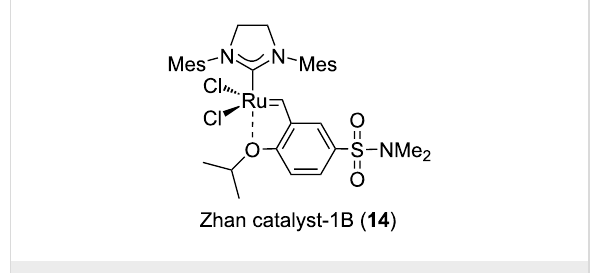
Figure 5: Structure of Zhan catalyst-1B ( 14 ) [14].